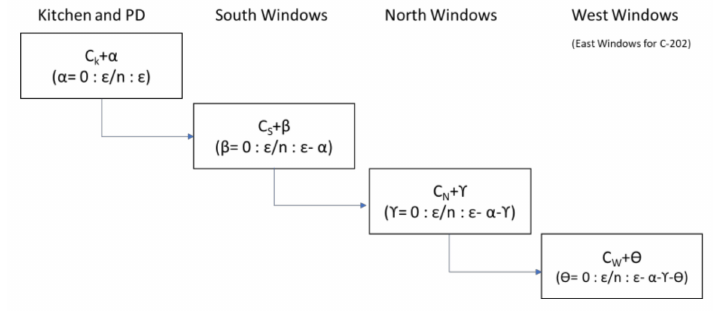
Figure 8. Parametric analysis process using JEPlus.